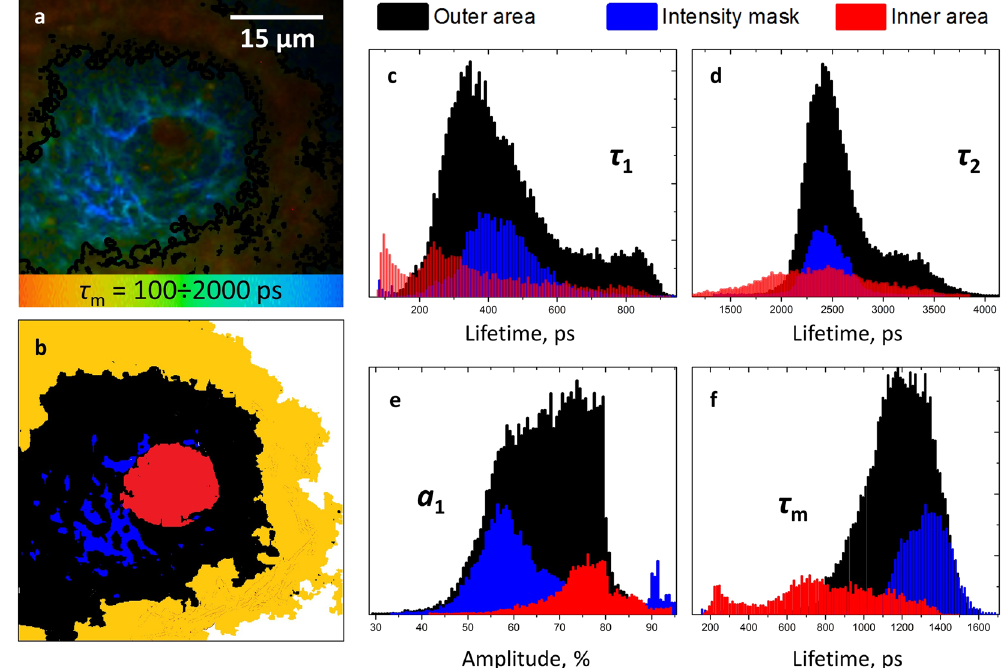
Figure 5. ( a ) FLIM image of the papillary structure, colors correspond to the values of mean fluorescence lifetime in the 100 ÷ 2000 ps range. ( b ) segmentation of the FLIM image of papilla into the inner area (red), outer area (black) and intensity mask area (blue). The yellow area corresponds to the melanin-rich area around the papilla. ( c – f ) – distributions of fast ( τ 1 ) and slow ( τ 2 ) decay components, amplitude of the fast component a 1 and mean fluorescence lifetime, respectively.